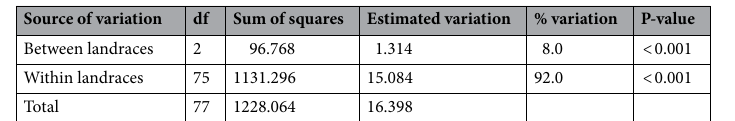
Table 4. Genetic variation of Bambara groundnut